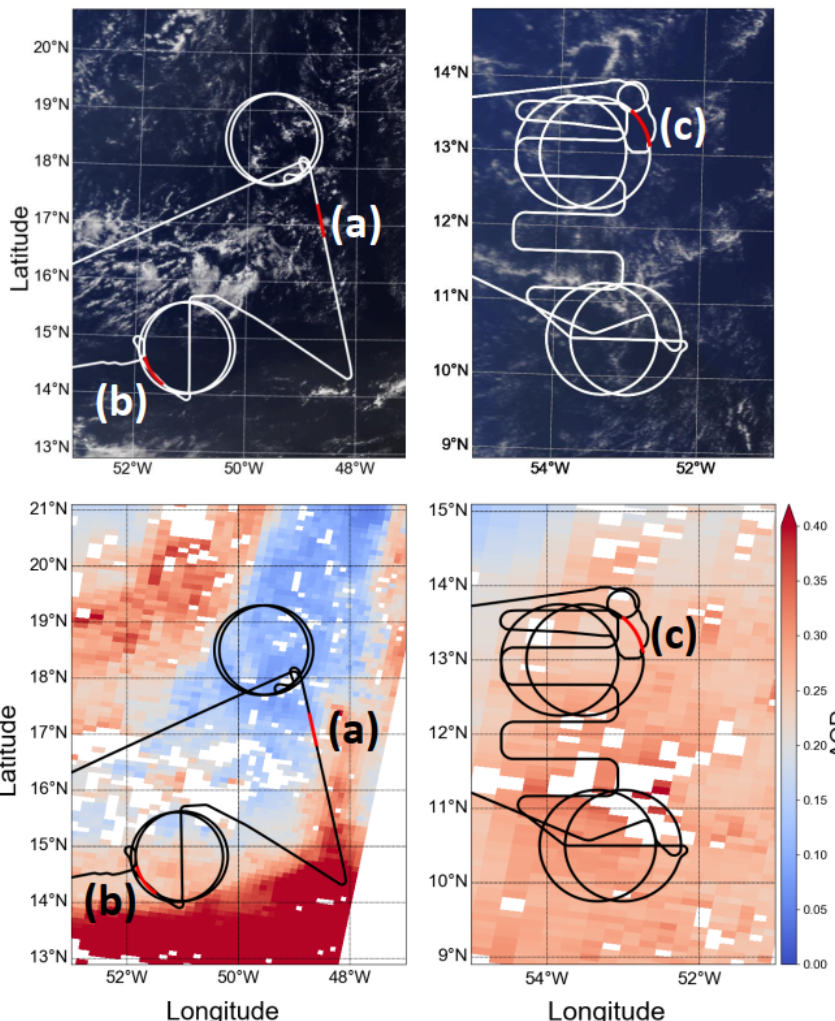
Figure 1. Flight tracks of the research flights conducted on 12 (right) and 19 (left) August 2016 on top of images showing MODIS (Moderate Resolution Imaging Spectroradiometer) true color (top) and aerosol optical depth (AOD, bottom) around 13:40UTC. Red lines and labels indicate the discussed flight segments (cases a, b and